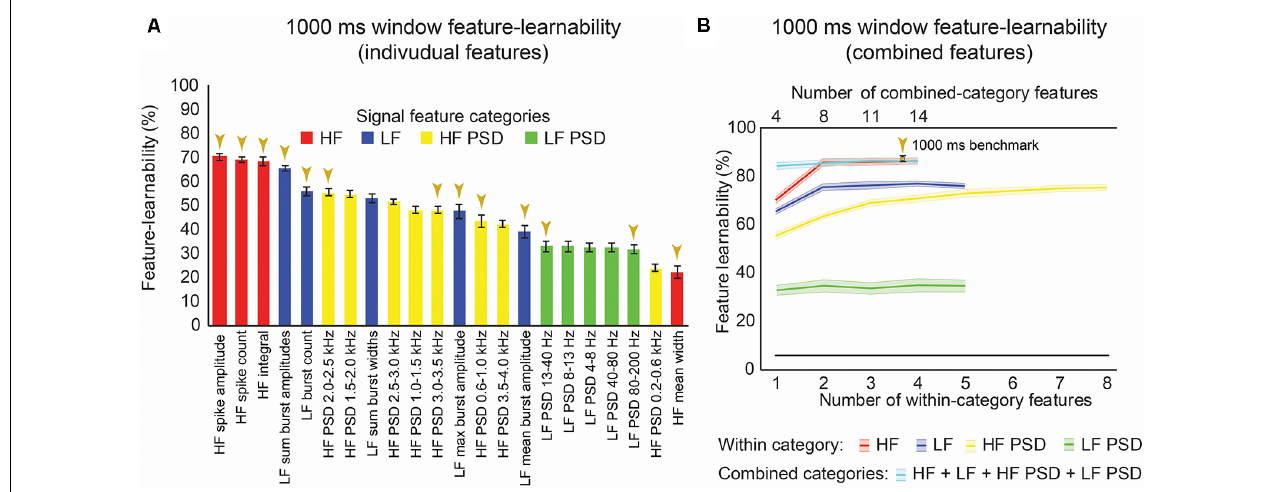
FIGURE 3 | One-thousand milliseconds window benchmark determined from individual and combined signal features. (A) Feature-learnability was derived from dorsal column nuclei signal features extracted from 1,000 ms windows starting at the onset of each stimulus. Features are ordered in feature-learnability rank order (Loutit et al., 2019) from highest to lowest feature-learnability from left to right. Colors indicate the feature category that individual features belong (as described in Figure 2 ). Gold arrows indicate the 13 signal features that comprise the 1,000 ms window benchmark configuration also indicated in panel (B) . (B) Feature-learnability was determined after consecutively adding individual features from the same category (within-category features) that improved classification accuracy. The number of individual features included in within-category combinations is indicated by the bottom x-axis; curves are color-coded according to the within-category features. Feature-learnability was also determined by combining the within-category features from all four categories (combined-category features, plotted in cyan). The total number of individual features included in the combined-category feature combinations is indicated by the top x-axis; the gold arrow indicates the 1,000 ms window benchmark configuration for all subsequent comparisons. The black line indicates a chance level of classification (6.25%). Feature-learnability data expressed as mean ± SEM. Abbreviations: HF, high-frequency, LF, low-frequency; HF PSD, high-frequency power spectral density; LF PSD, low-frequency power spectral density. See Figure 2 for feature name